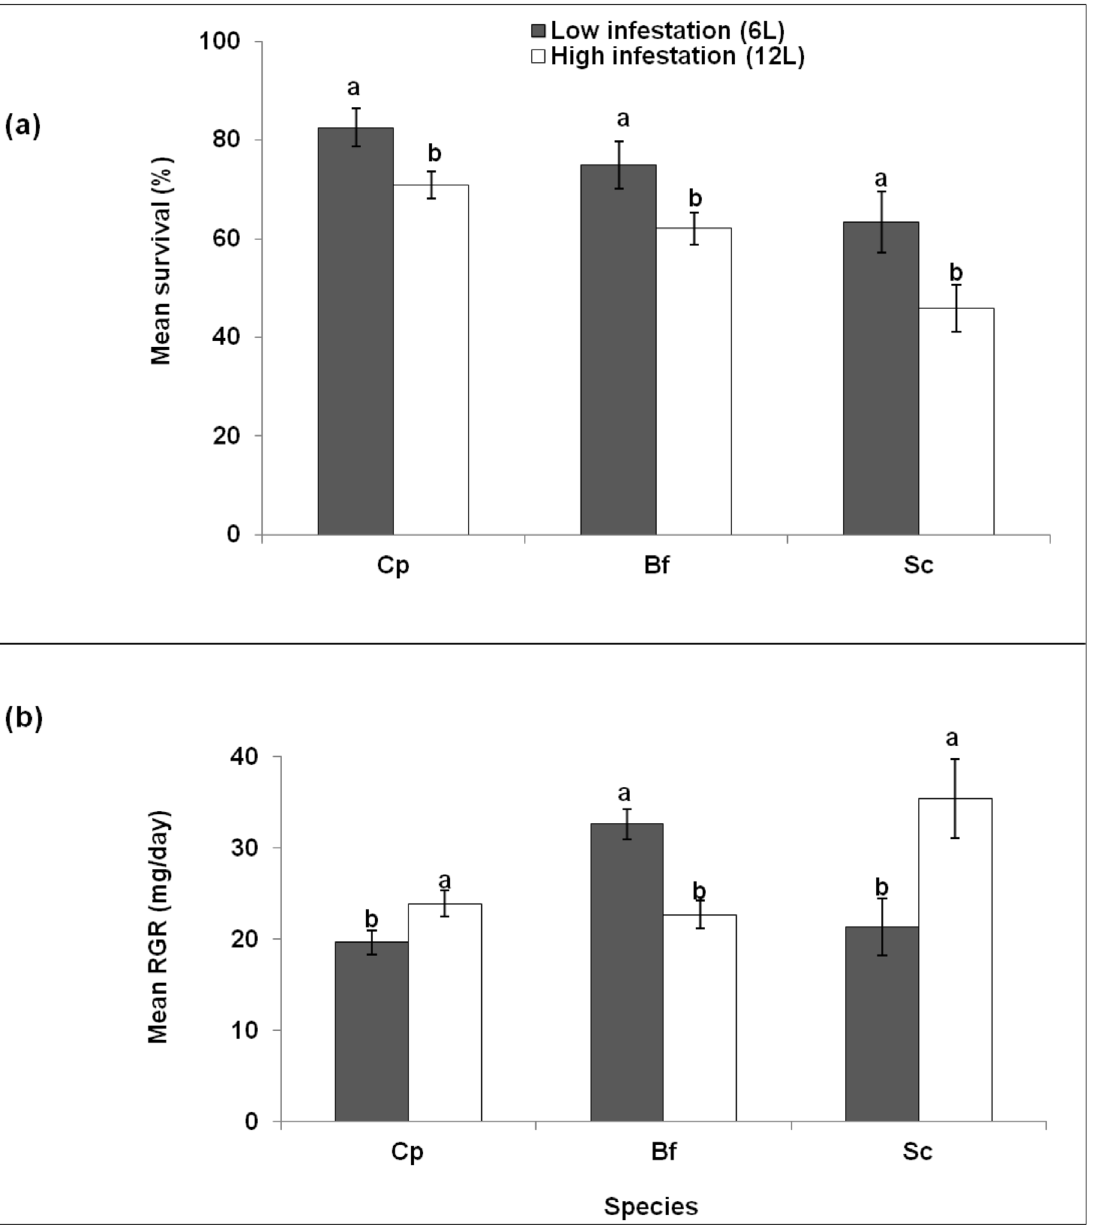
Fig 3. Survival (a) and relative growth rates (b) of Chilo partellus (Cp), Busseola fusca (Bf) and Sesamia calamistis (Sc) at low density (6L) and high density (12L) infestation at 25°C. Means ( ± SE) with different letters are significantly different at 5% level according to the GLM for survival and the Student- Newman-Keuls test for relative growth